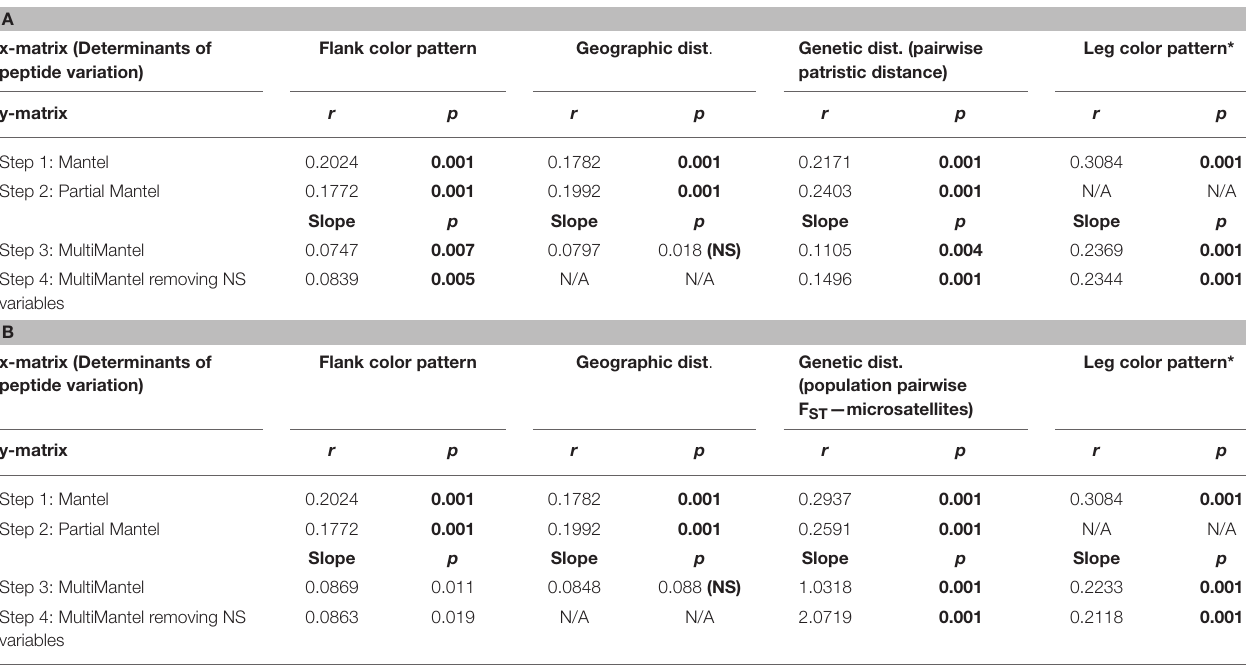
A x-matrix (Determinants of peptide